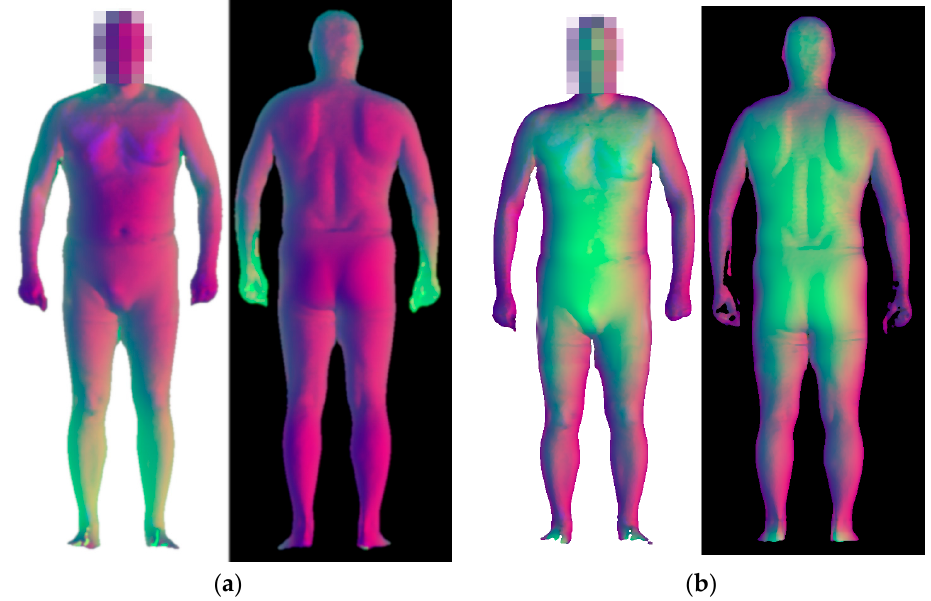
Figure 15. Images generated using orthogonal projection ( a ) and mid-surface projection ( b ).